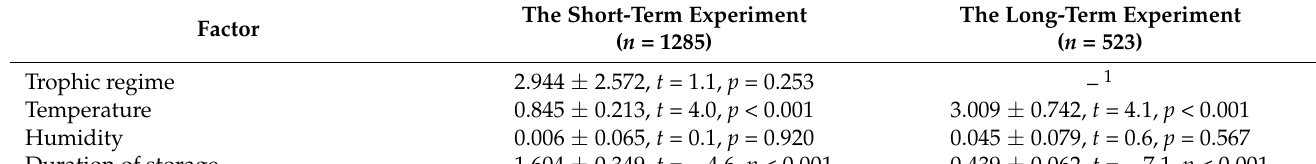
Figure 3. Fecundity of Cheilomenes propinqua females in relation to their size, as estimated by the hind femur length. Each symbol corresponds to one control female. The dashed line shows the linear